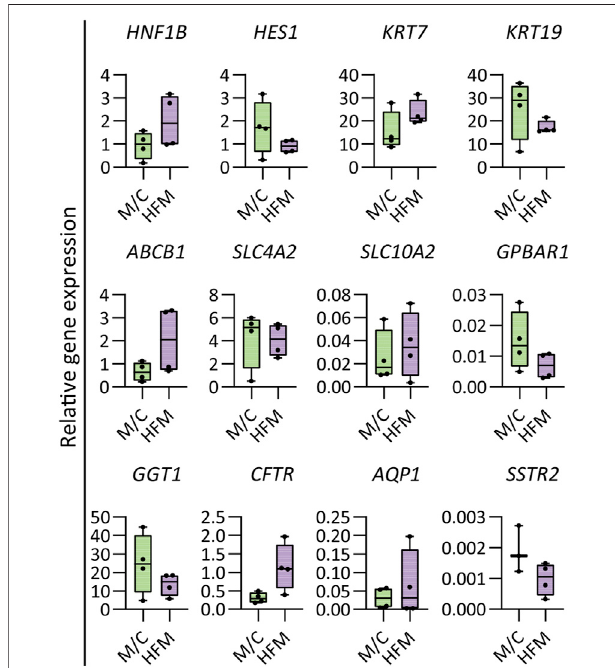
FIGURE 2 | Gene expression in mature bile ducts. Gene expression analysis demonstrating the HFM culture maintained cholangiocyte characteristics and expressed some more mature cholangiocyte characteristics compared to M/C-cultured CLCs. Results are shown as foldchangerelativetothehumangallbladderforcholangiocytemarkers. N =4 independent donors for M/C- and HFM-cultured CLCs in CDM conditions on day 7. Data are shown as box and whisker plots. Center line, median; box, interquartile; whiskers: minimum to maximum and show all points. Statistical differences between groups were analyzed using the two-tailed Mann – Whitney U test (see also Supplementary Table S4 ).